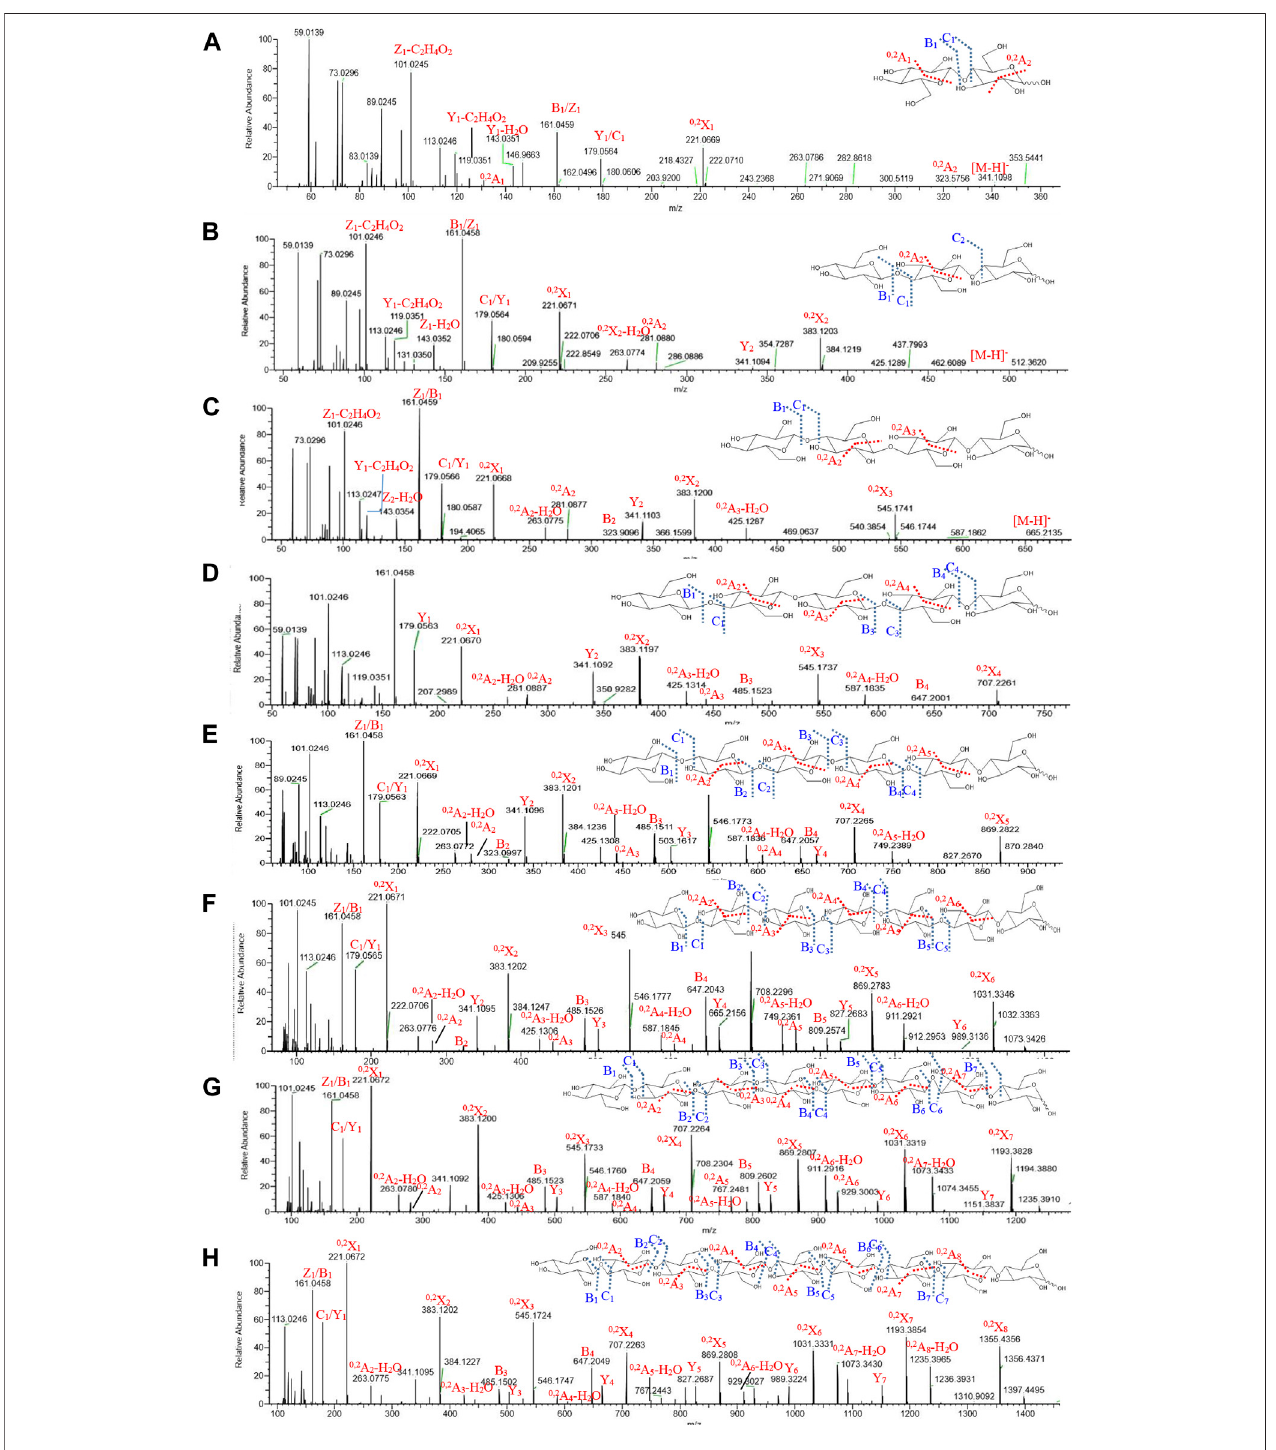
FIGURE 5 | Mass spectra of two to nine sugars from APOS (A – H)